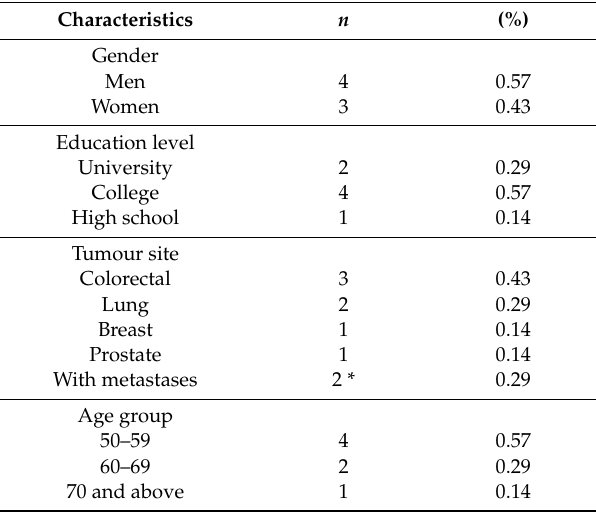
Table 2. Participant characteristics ( n =